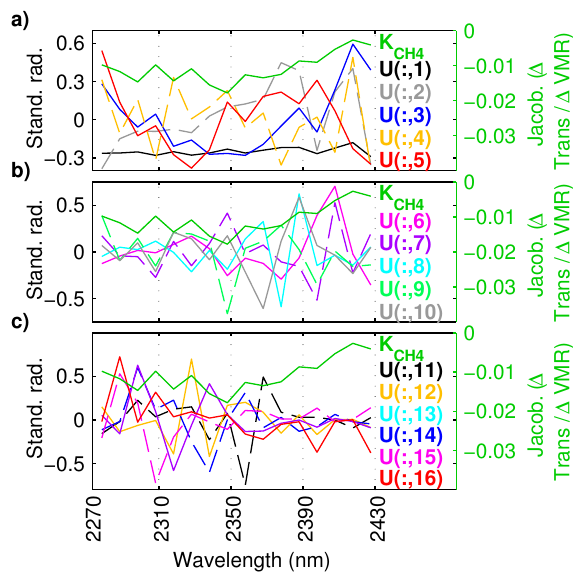
Fig. 10. (a) Singular vectors contained in U econ for COP scene with ) plotted for reference. CH 4 Jacobian ( K CH 4